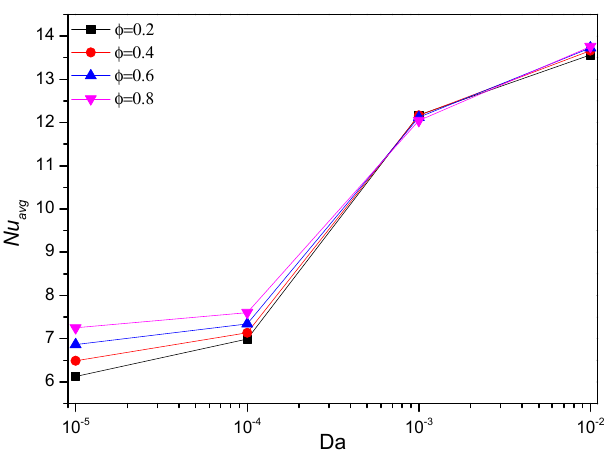
Figure 24. Average Nusselt number (Nuave) as a function of Darcy number (Da) at various values of φ . Ra = 10 6 , ε = 0.4 and Ha = 0.